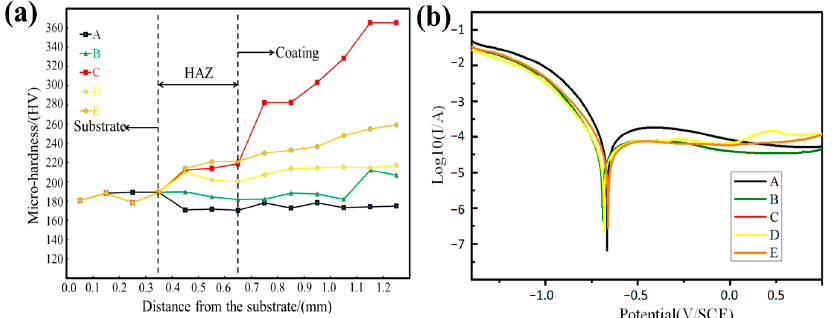
Figure 8. Mechanical properties of the HEA/WC coating. ( a ) The hardness distributions of HEA/WC composite coatings; ( b ) the potentiodynamic polarization evolution curves of HEA/WC composite coatings.